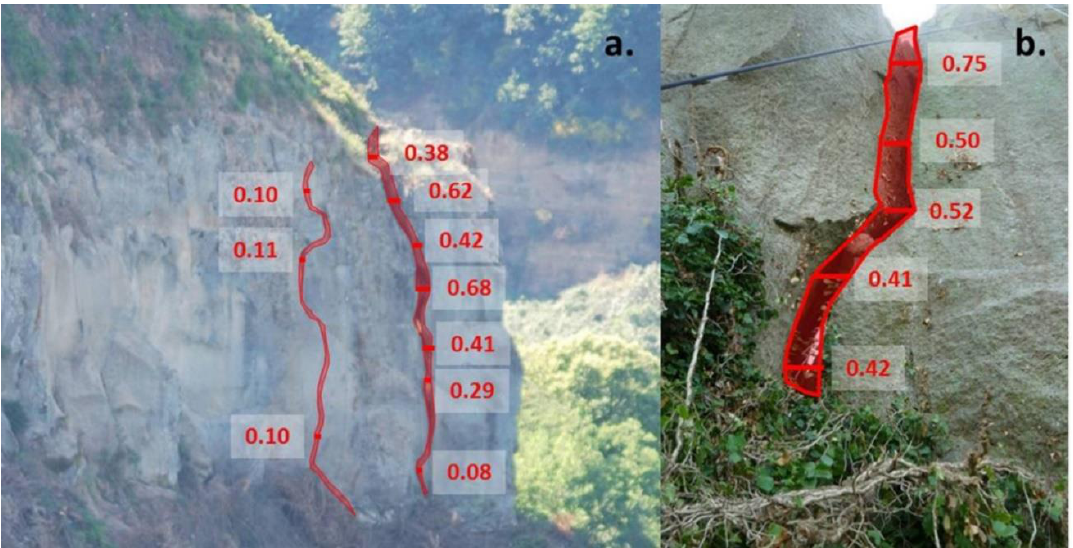
Figure 9. Opening values of fractures measured in a released area of the cliff at the intersection of the east ( a ) and north ( b ) sectors of the cliff.